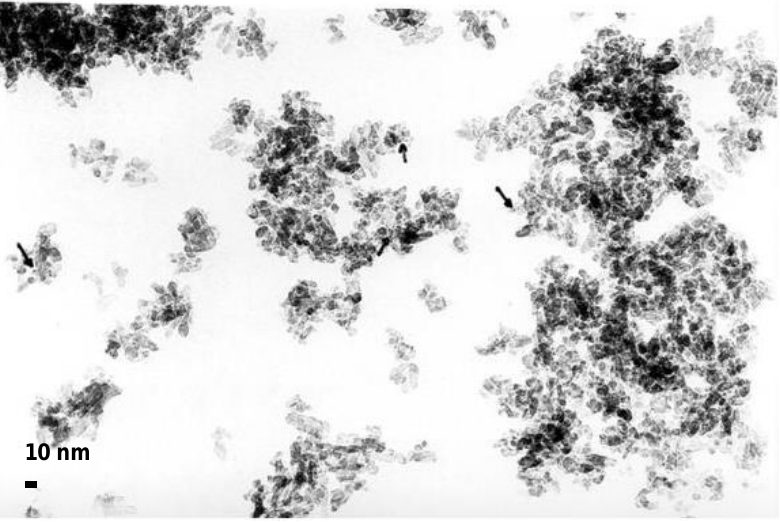
Figure A3. Microphotography of Ru/Al 2 O 3 -K(1 wt%) catalyst.